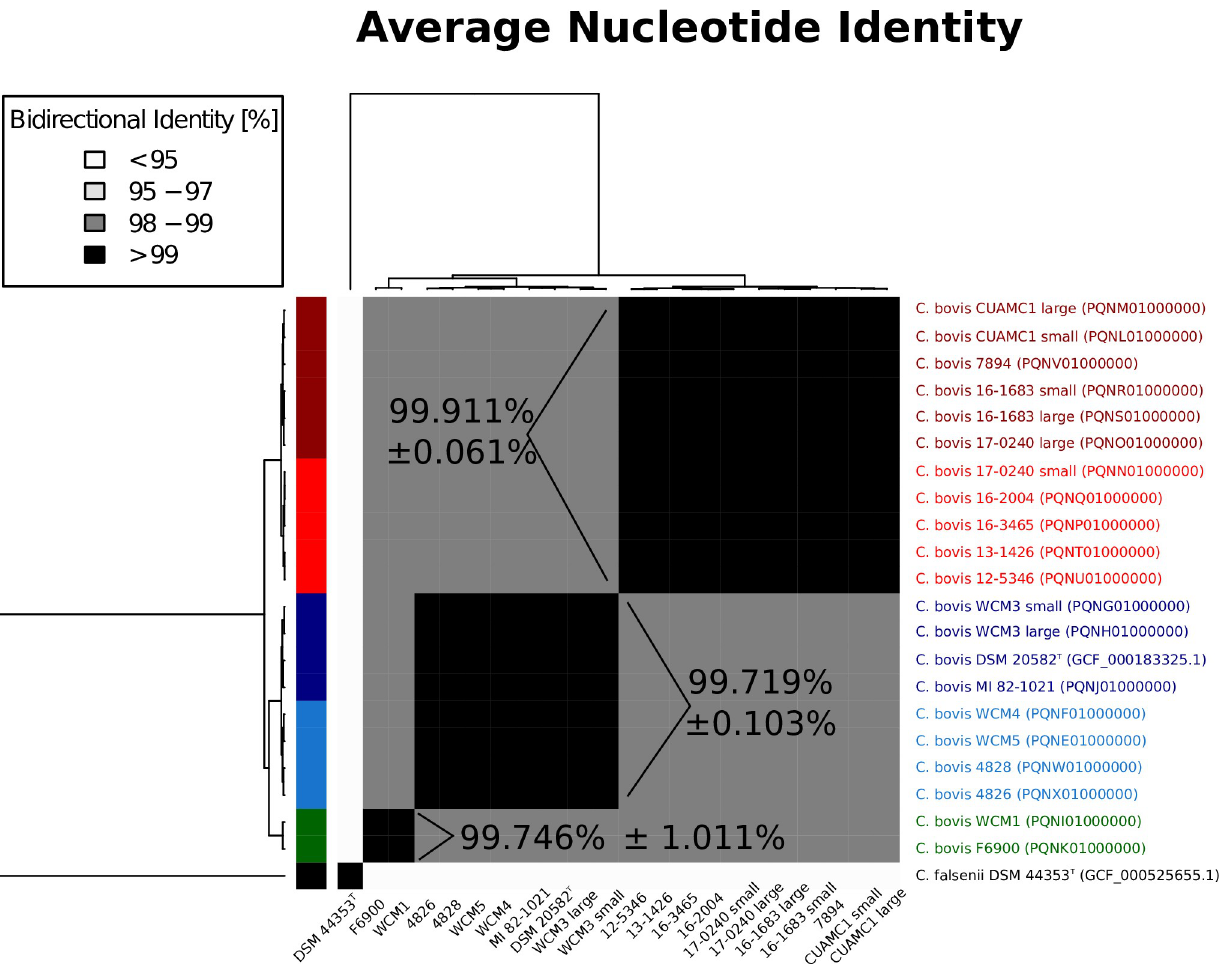
Fig 2. Genomes clustered according to pairwise average nucleotide identity (ANI) distances. Each pairwise ANI result is represented in a greyscale square, with none occurring between 95–97%. Corynebacterium falsenii is shown as a neighboring outlier to the C . bovis genomes (n = 21). Six clusters are color-coded in the left dendrogram (black, green, blue, dark blue, red, and dark red). When the genomes are clustered into just four groups, the blue and dark blue clusters collapse into one group, and the red and dark red clusters merge as well. ANI percentages shown for three select groups represent arithmetic means and standard deviations of bi-directional